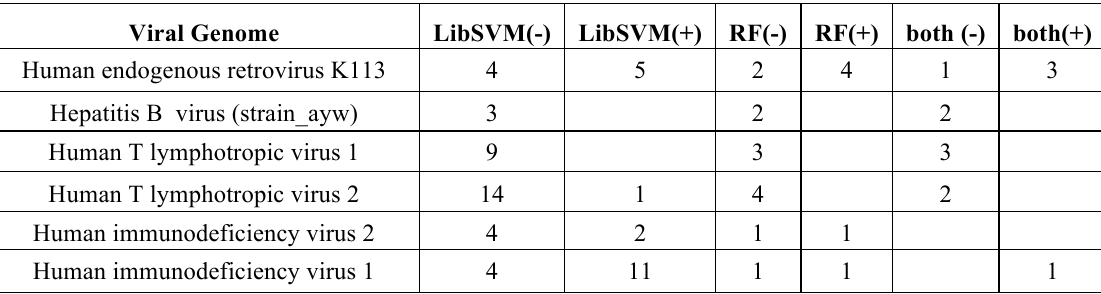
Table 2: Number of predicted hairpins in 5 virus genomes by using models learned from known human hairpins. RF: random forest, + and - indicate strands. Prediction score cut-off value is